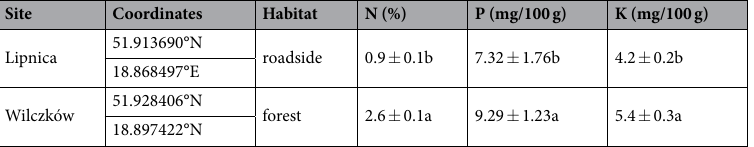
Table 1. Site characteristics and soil macronutrient (N, P or K) content (total N%, others mg/100 g). Statistical comparisons (Student’s t-test) within a column only; different letters beside means denote significant differences between habitats at p < 0.05. Data are means ( ± SD) from five samples at each habitat.